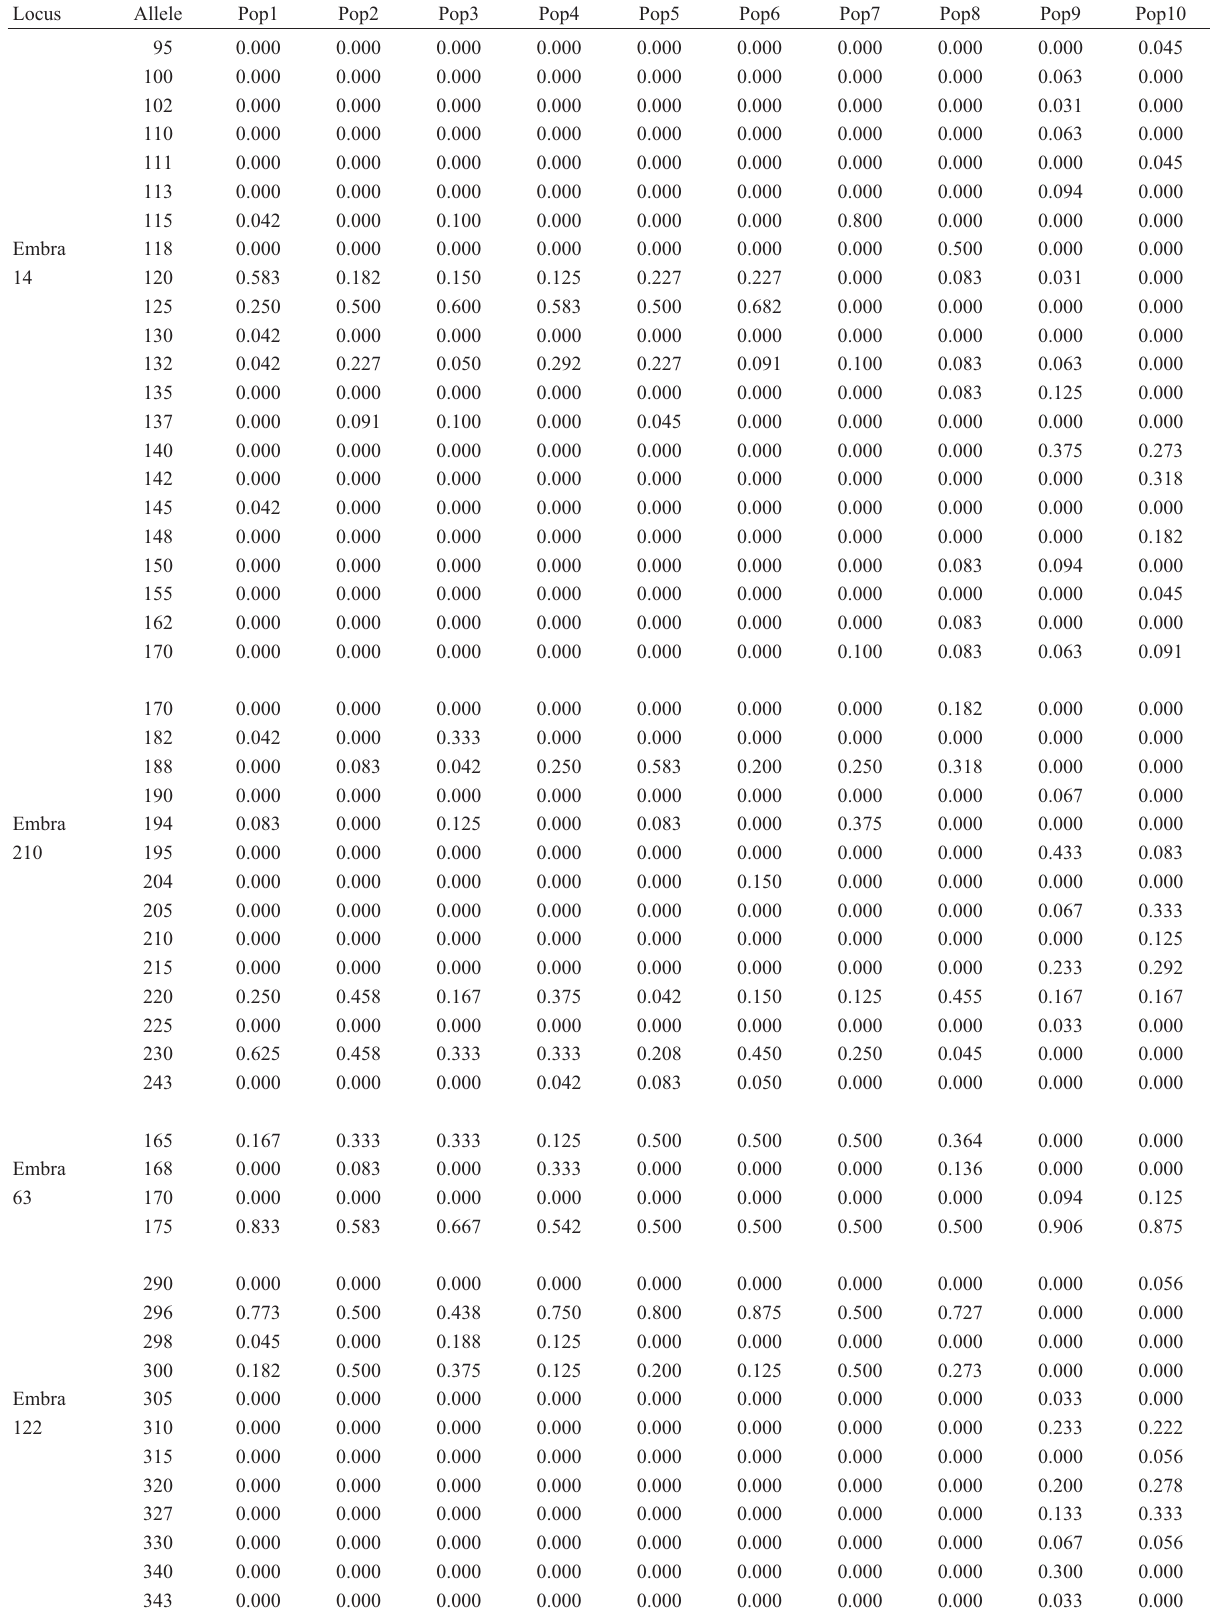
Table 3 - Table of allelic frequencies of the seven SSR loci, estimated from 116 individuals of 10 populations of Eugenia dysenterica .